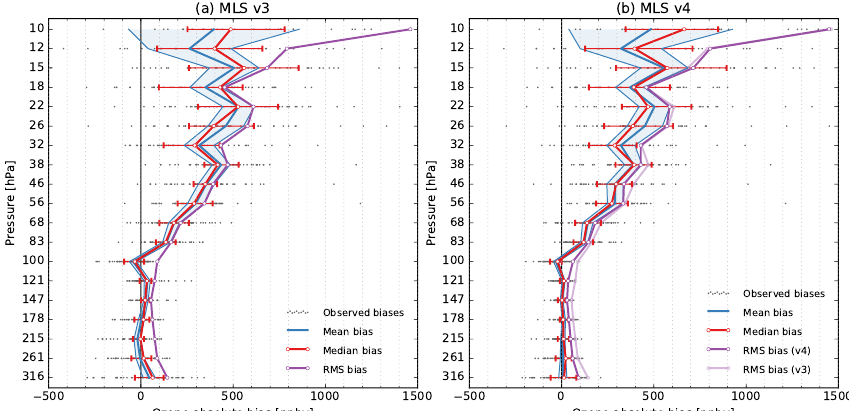
Figure 13. As in Fig. 4, but for absolute biases between ECC and (a) MLS v3 and (b) MLS v4 profiles of ozone volume mixing ratio.